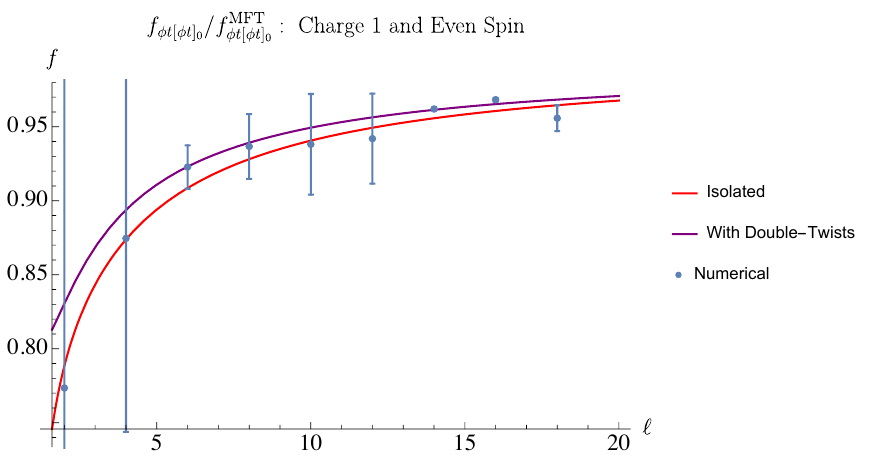
Figure 32 . The e(cid:11)ects of DTIs for OPEs of di(cid:11)erent low-lying double twists in the charge 1 [ (cid:30)s ] 1 odd-spin sector.